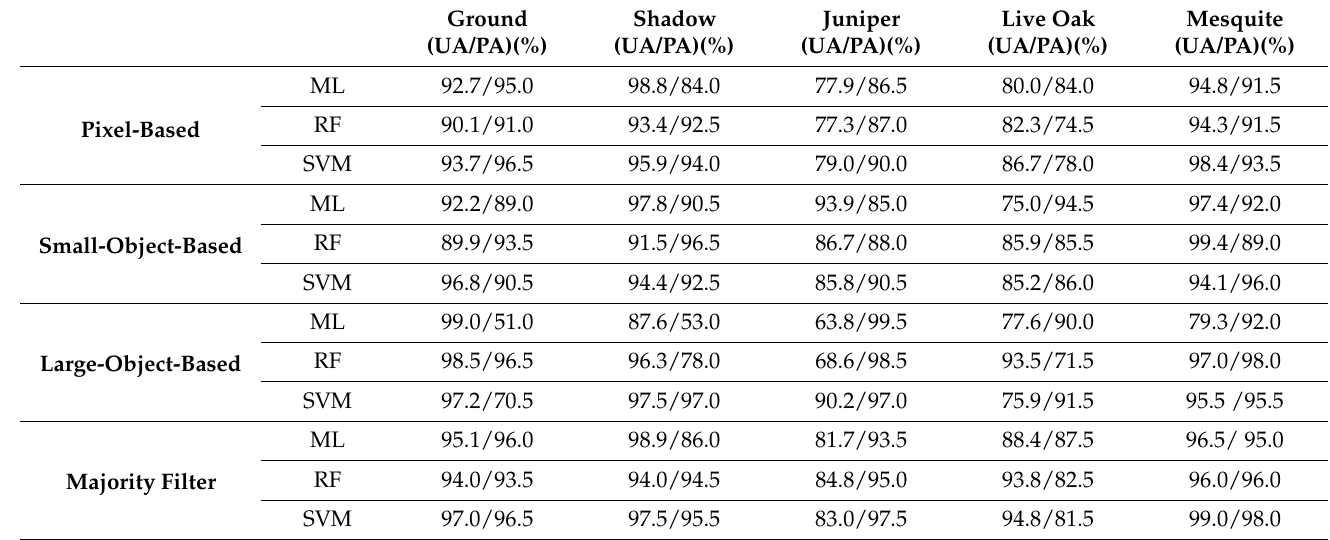
Table 3. User and producer accuracies for the traditional and machine learning